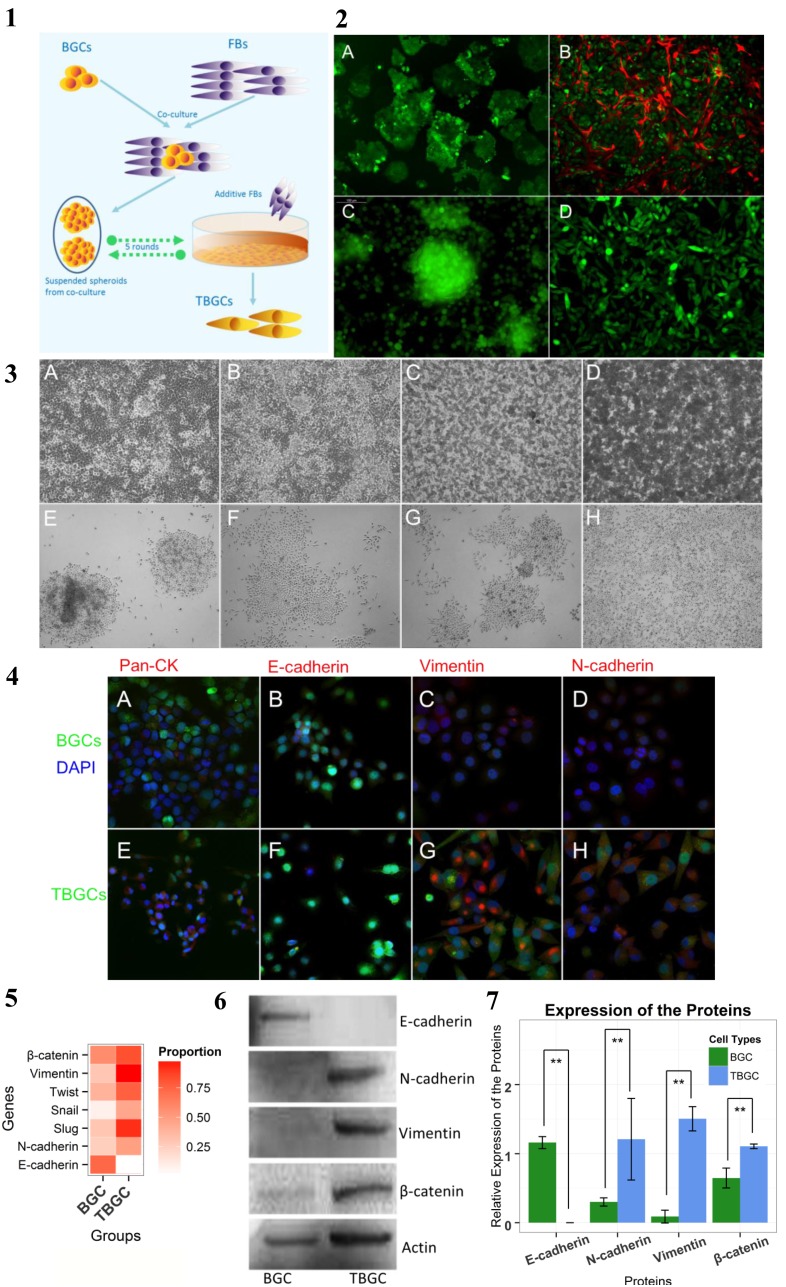
Morphological changes in BGC-823 cells were associated with the epithelial-mesenchymal-transition.
Figure 1.1. Schematic of the experimental protocol.
Figure 1

.2. Origin of the supernatant cells. (A) GFP-labeled BGC-823 cells (green). (B) BGC-823 cells that were cocultured with fibroblasts (red). (C) BGC-823 cells grew into clumps and demonstrated round shapes in suspension. (D) TBGCs were induced by coculturing. Magnification 100×.
Figure 1

.3. Transformation from BGC-823 cells to TBGCs under a phase-contrast microscope. (A–D) BGC-823 cells in a dense culture system can form clusters and shed off cells into the suspension. (E–H) Passage of suspended tumor cells.
Figure 1

.4. Immunofluorescent staining of pan-CK (red), E-cadherin (red), vimentin (red) and N-cadherin (red). BGC-823 cells (above) and TBGCs (below) were labeled with GFP (green). The nucleus was stained with DAPI (blue).
Figure 1

.5. Heat plot of gene expression profiles analyzed using fluorescence quantitative RT-PCR. The depth of the color indicates relative gene expression.
Figure 1

.6. Western blots of proteins.
Figure 1

.7. Bar plot of protein expression determined using Western blot analysis. Bars denote the relative expression levels measured using IOD. Vertical lines denote standard differences. **p<0.01.